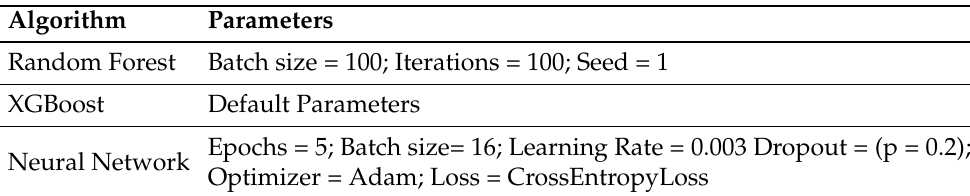
Table 5. Selected Parameters for